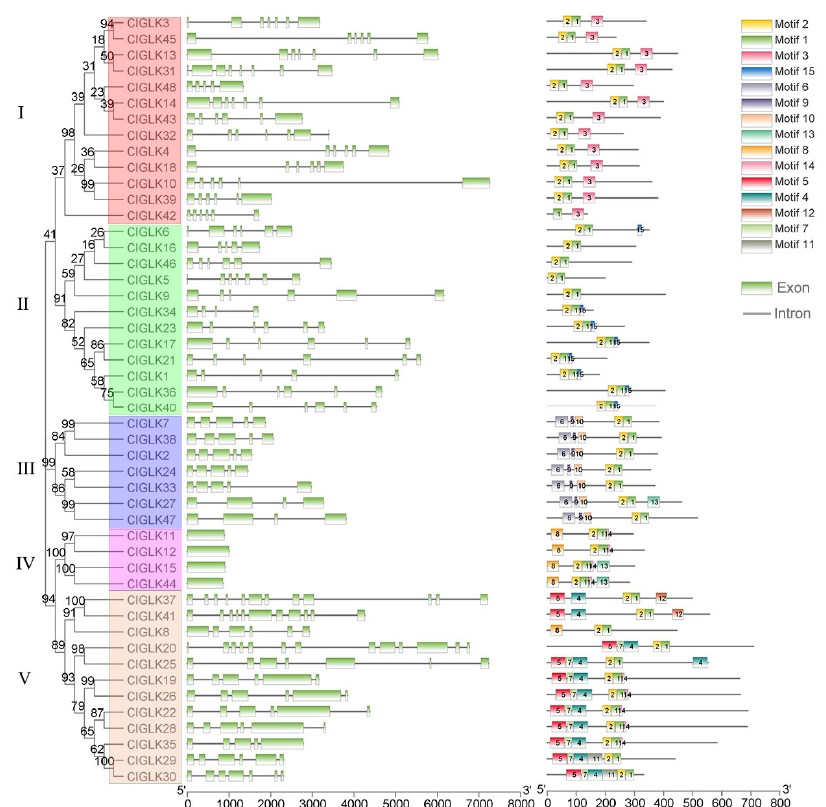
Figure 1. Analysis of the phylogenetic relationships, gene structures, and conserved motifs of GLKs in watermelon.